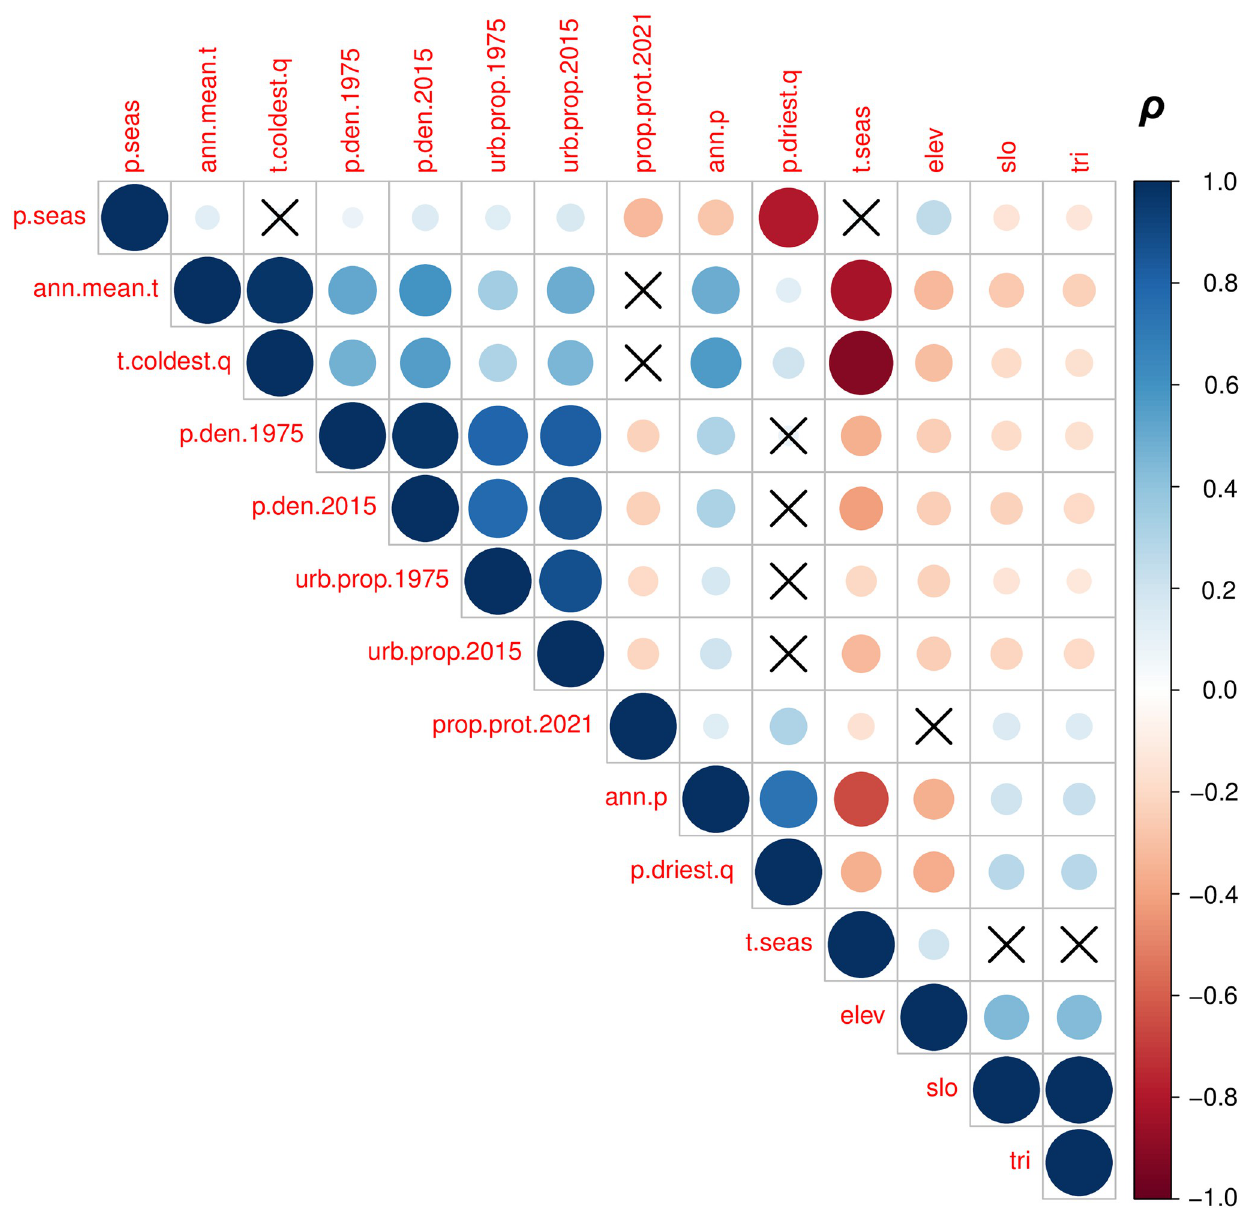
Fig 7. Spearman’s Rank Correlation matrix of population and spatially averaged potential covariate data across sub-divided “Low”, “Middle”, and “High” GMBA mountain polygons for the historical period. p.seas denotes mean precipitation seasonality according to WorldClim v2.1, ann.mean.t annual mean temperature according to WorldClim v2.1, t.coldest.q the mean temperature of the coldest quarter according to WorldClim v2.1, p.den.1975 population density in 1975 according to GHS-POP (a “dependent variable”), p.den.2015 population density in 2015 according to GHS-POP (a second “dependent variable”), urb.prop.1975 the areal proportion of each zone considered urban in 1975 according to GHS-SMOD, urb.prop.2015 the areal proportion of each zone considered urban in 2015 according to GHS-SMOD, prop.prot.2021 the areal proportion of each zone considered protected according to the May 2021 release of the World Database on Protected Areas (WDPA), ann.p mean annual (sum) precipitation according to WorldClim v2.1, p.driest.q mean precipitation (sum) of the driest quarter according to WorldClim v2.1, elev is mean elevation according to the MERIT terrain model, slo is mean slope angle according to the Geomorpho90 dataset, and tri is topographic roughness index according to the Geomorpho90 dataset (see S5 Table in S1 File for further details on these datasets). A value of +1 indicates a perfect positive correlation, whilst -1 indicates a perfect negative correlation (sphere size is also proportional to relationship strength). Relationships that are statistically insignificant at the 0.01 confidence level are indicated with crosses.